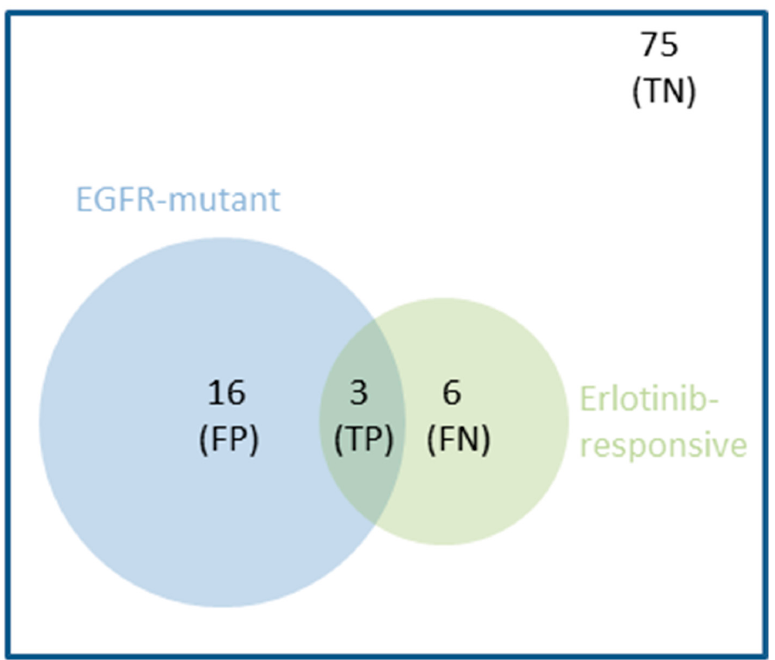
Figure 1. Venn diagram showing the performance of a representative single-gene marker, which predicts that EGFR-mutant NSCLC patients are sensitive to the Erlotinib drug. In a clinical study [8], 100 NSCLC patients were treated with Erlotinib, 19 of them harbouring EGFR-mutant tumours. However, despite being an FDA-approved genomic marker [2], the mutational status of EGFR was a modest predictor of NSCLC tumour response to Erlotinib: 84% (16/19) of EGFR-mutant tumours did not respond. This false positive (FP) rate also means that only 16% (3/19) of these tumours turned out to be responsive (precision of 0.16). Furthermore, 7% (6/81) of NSCLC tumours with wild-type EGFR actually responded to the drug. This false negative (FN) rate means that only 33% (3/9) of the responsive tumours were recalled by this predictor (recall of 0.33). Thus, this case is representative of single-gene markers in that their performance is generally quite modest [5,6]. Intuitively, one can see how combining multiple gene alterations could result in a predictor (blue circle = EGFR-mutant patients predicted to be erlotinib-responsive) having a better overlap with the set of responsive tumours (green circle = observed erlotinib-responsive patients) by decreasing FPs and FNs. The overlap hence corresponds to the number of true positives (TP). Lastly, patients who do not fall into any of these three non-overlapping categories are true negatives